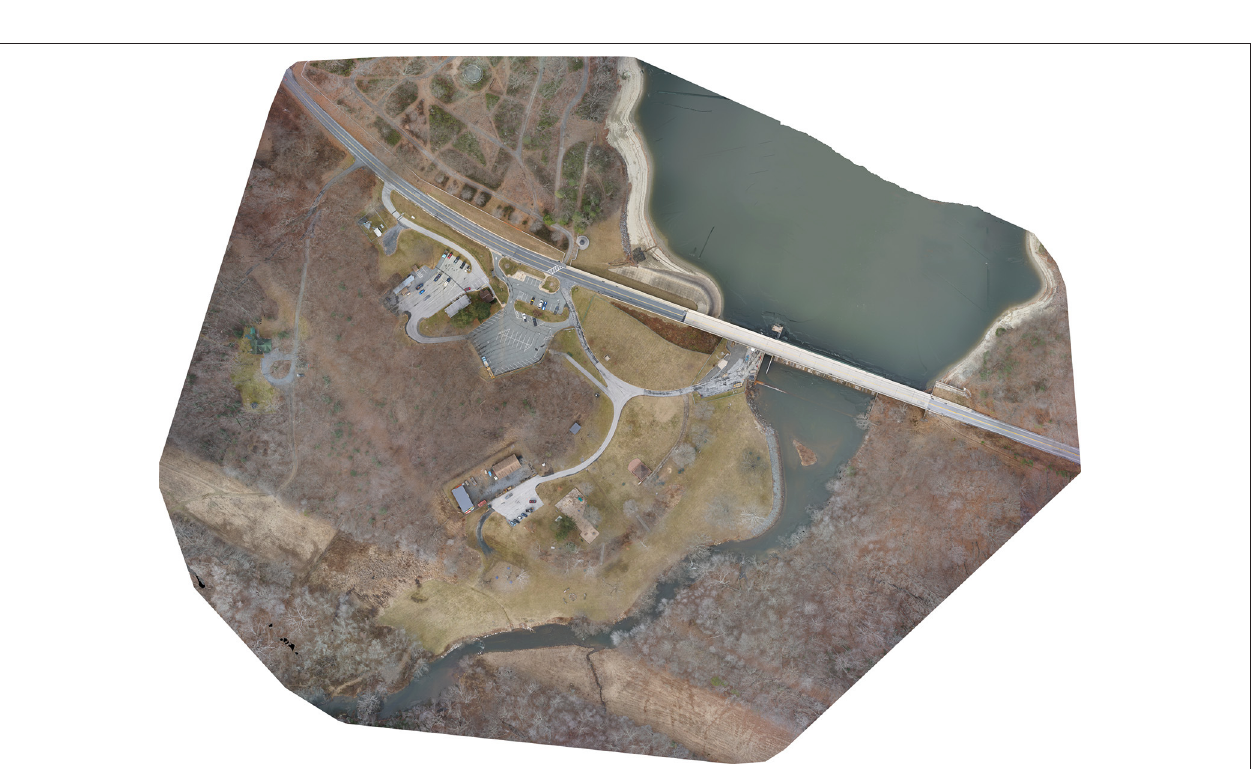
FIGURE 3 | Orthomosaic generated using the fixed wing imagery dataset.